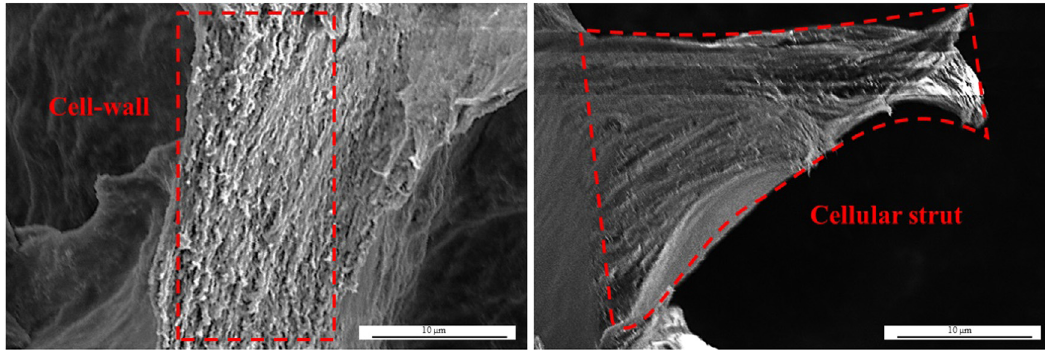
Figure 8: Cross section of cellular wall of BPLA/CNT foams.